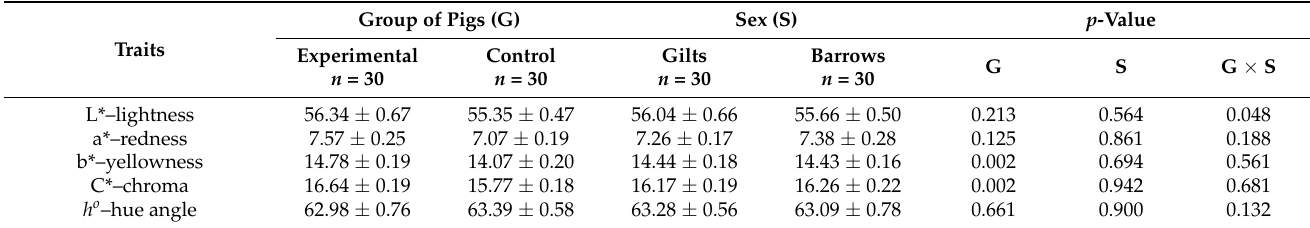
Table 6. Color traits of the LL muscle.